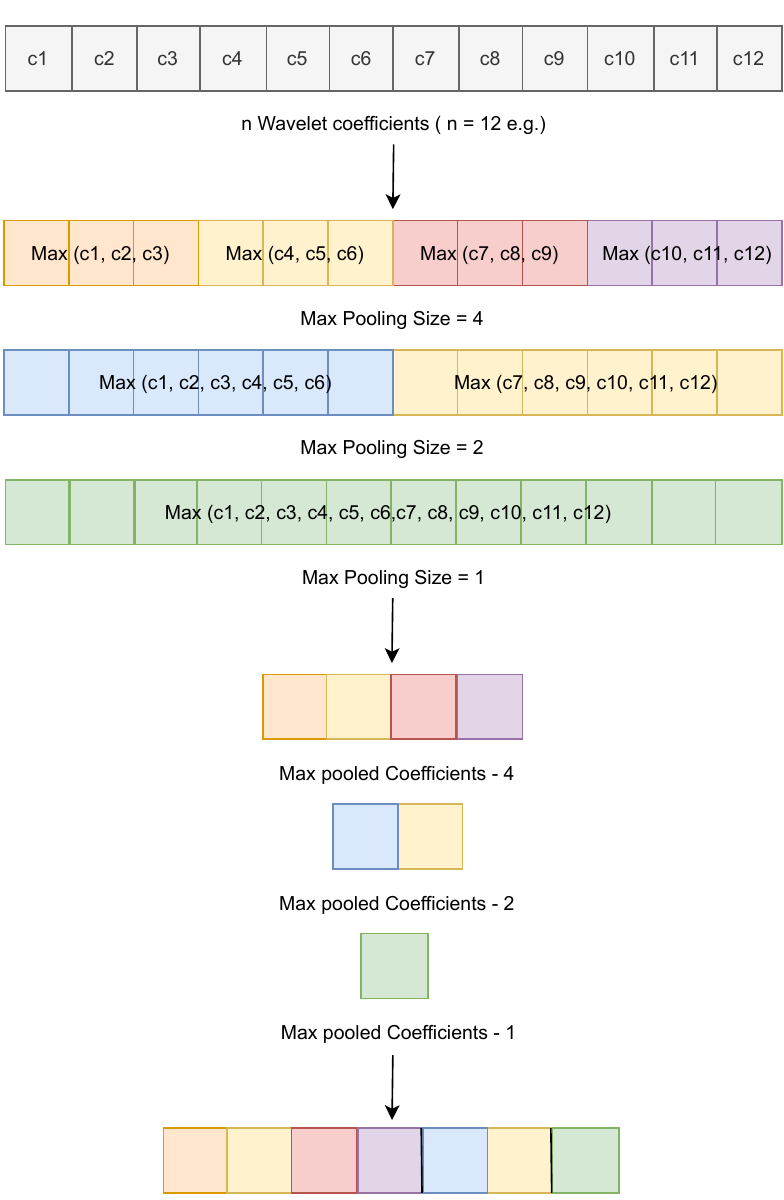
Figure 2. Example: 4-2-1 1-D Spatial Pyramid